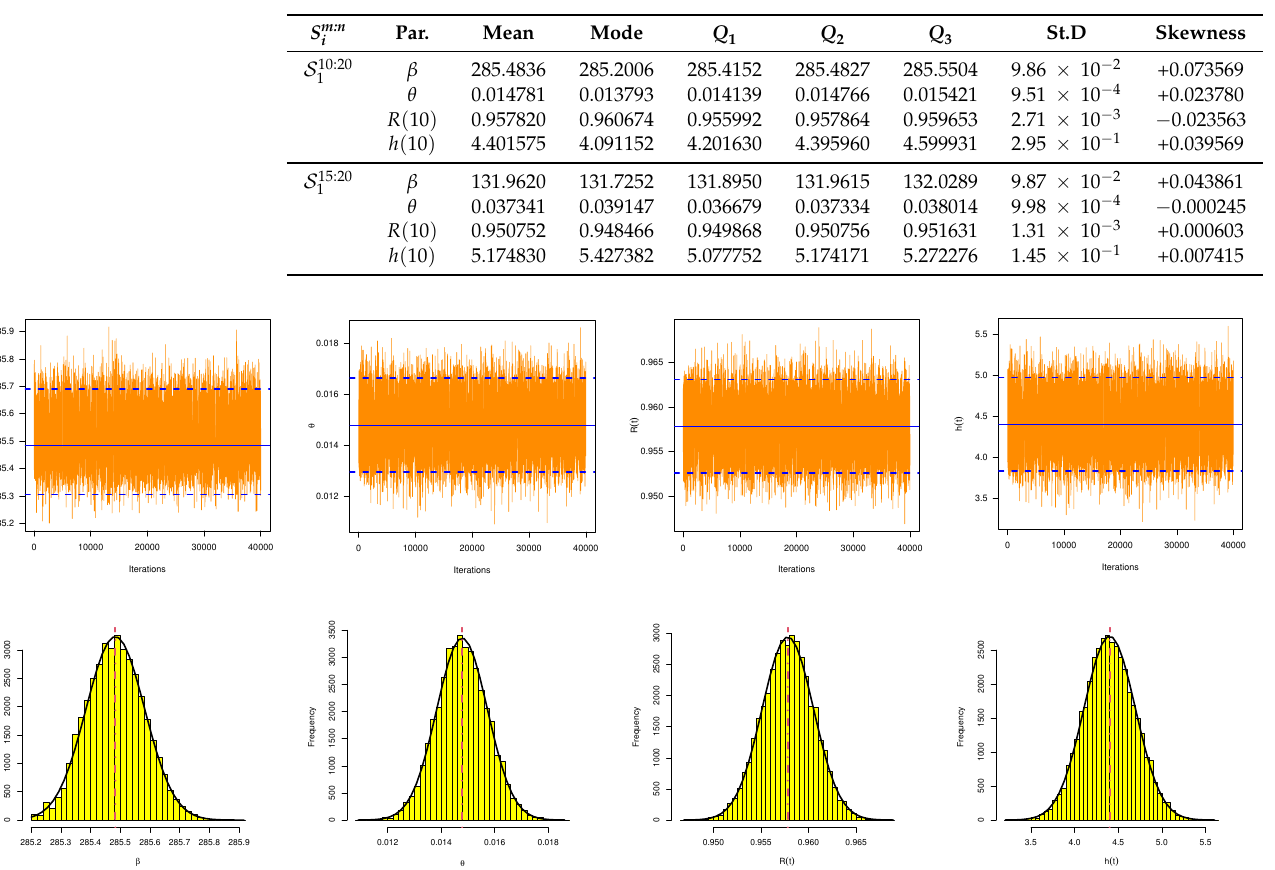
Figure 8. Trace ( top panel) and Histogram ( bottom panel) plots of β , θ , R ( t ) , and h ( t ) under SSB